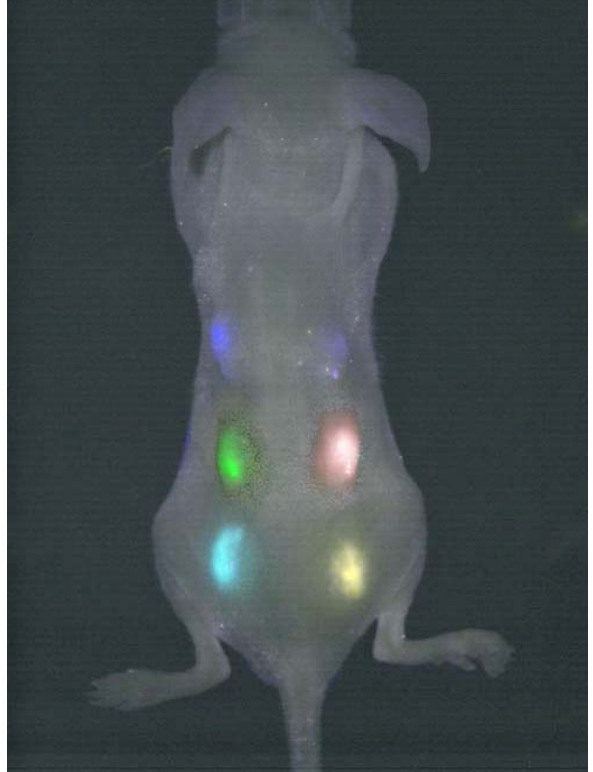
Figure 3. Embryonic stem cells labeled with six different QDs were subcutaneously injected on the back of the athymic nude mice right after labeling (image taken with a single excitation light source right after injection). Reprinted with permission from